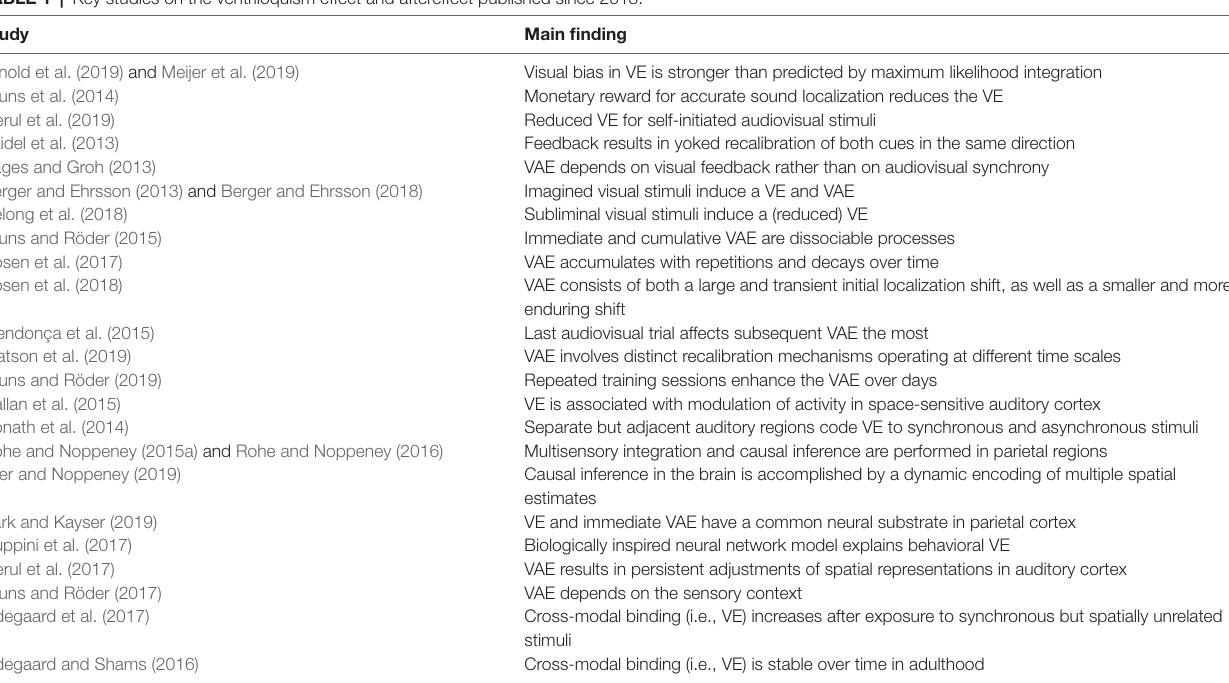
TABLE 1 | Key studies on the ventriloquism effect and aftereffect published since 2013.